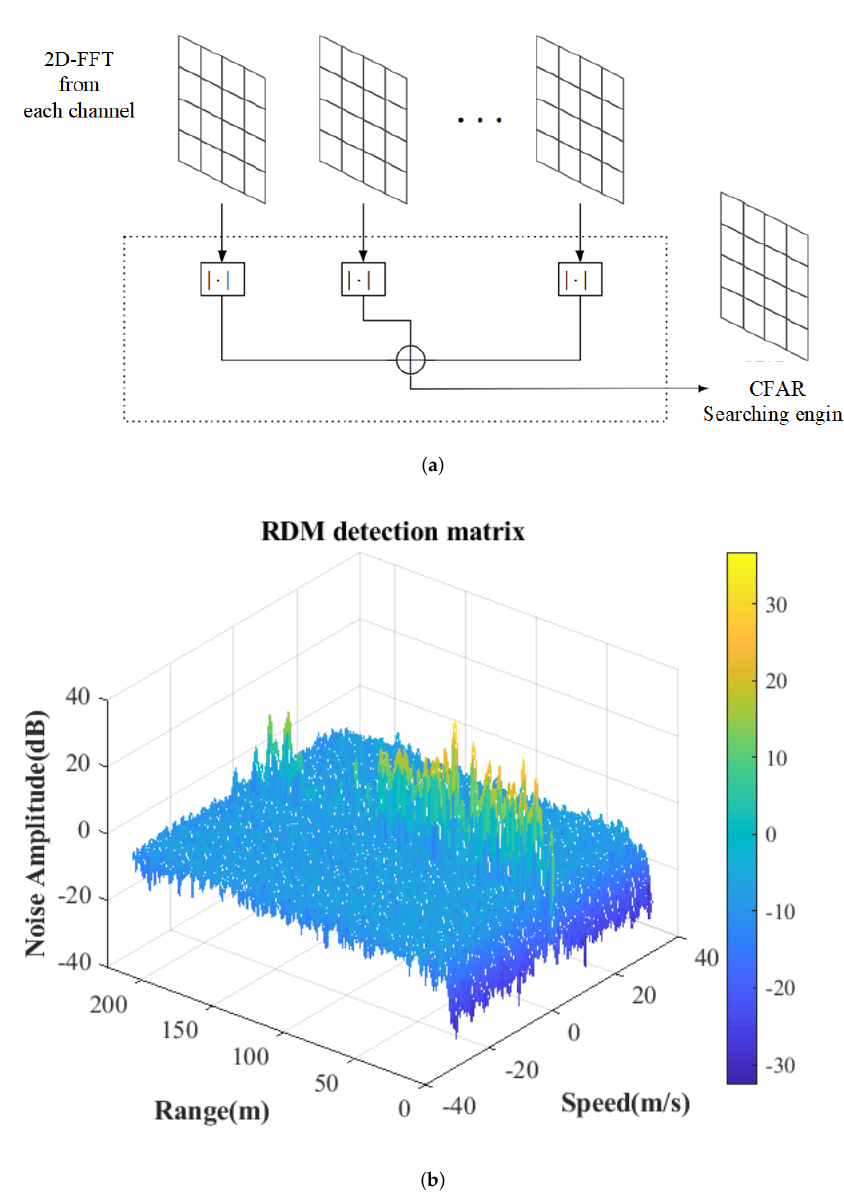
Figure 7. ( a ) RDM data acquisition process. ( b ) Data collection